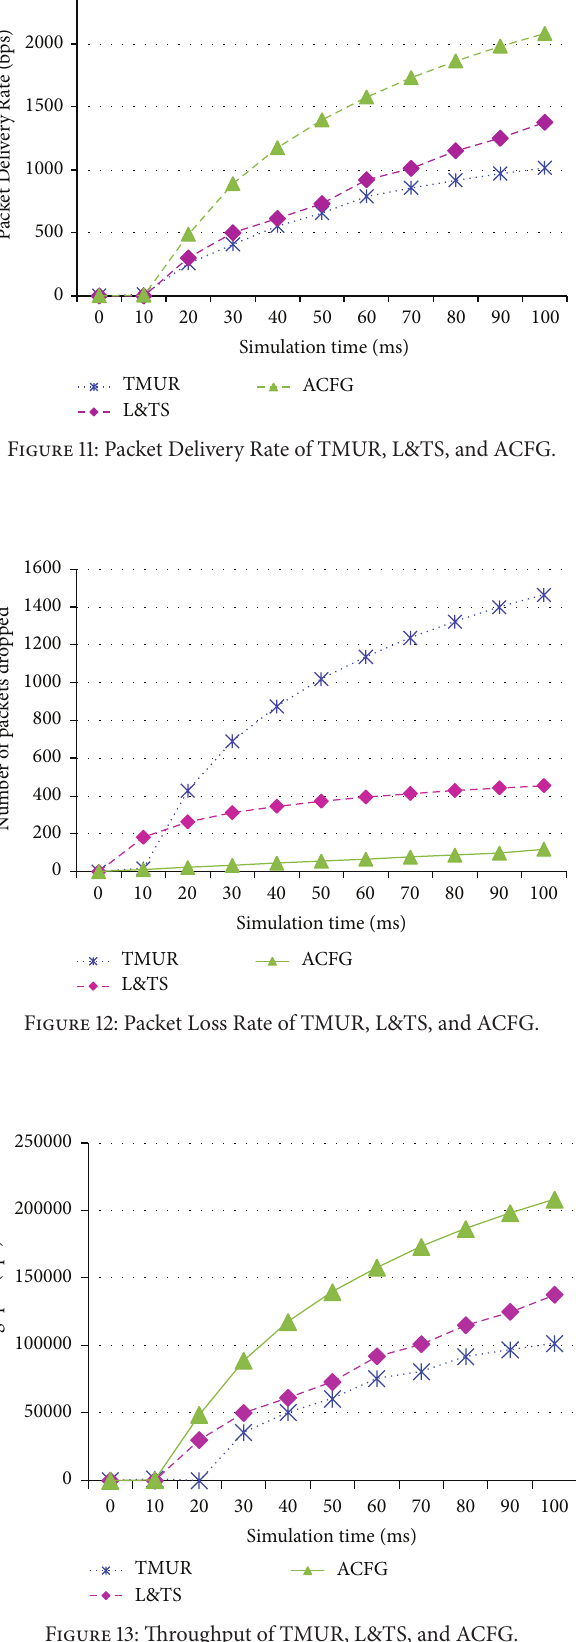
Table 1: Simulation parameters.